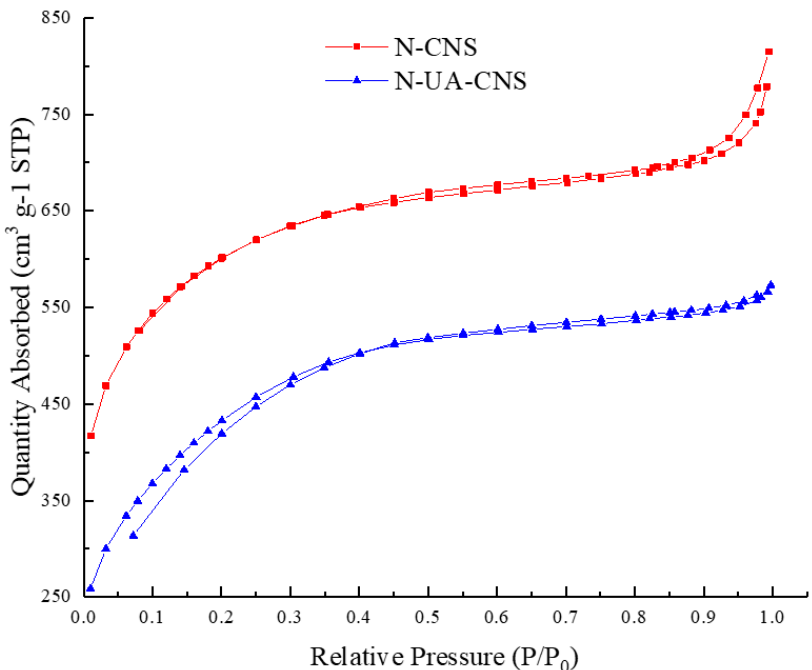
Figure 2. Nitrogen adsorption-desorption isotherms of the self-doped-nitrogen porous carbon nanosheets (N-CNS) and the unactivated self-doped-nitrogen porous carbon nanosheets(N-UA-CNS).